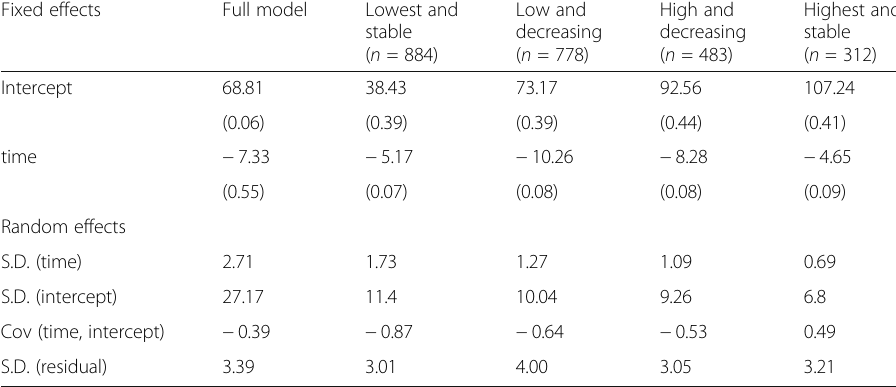
Table 7 Latent growth curves models of SLI-R. Mexico 2000 – 2015